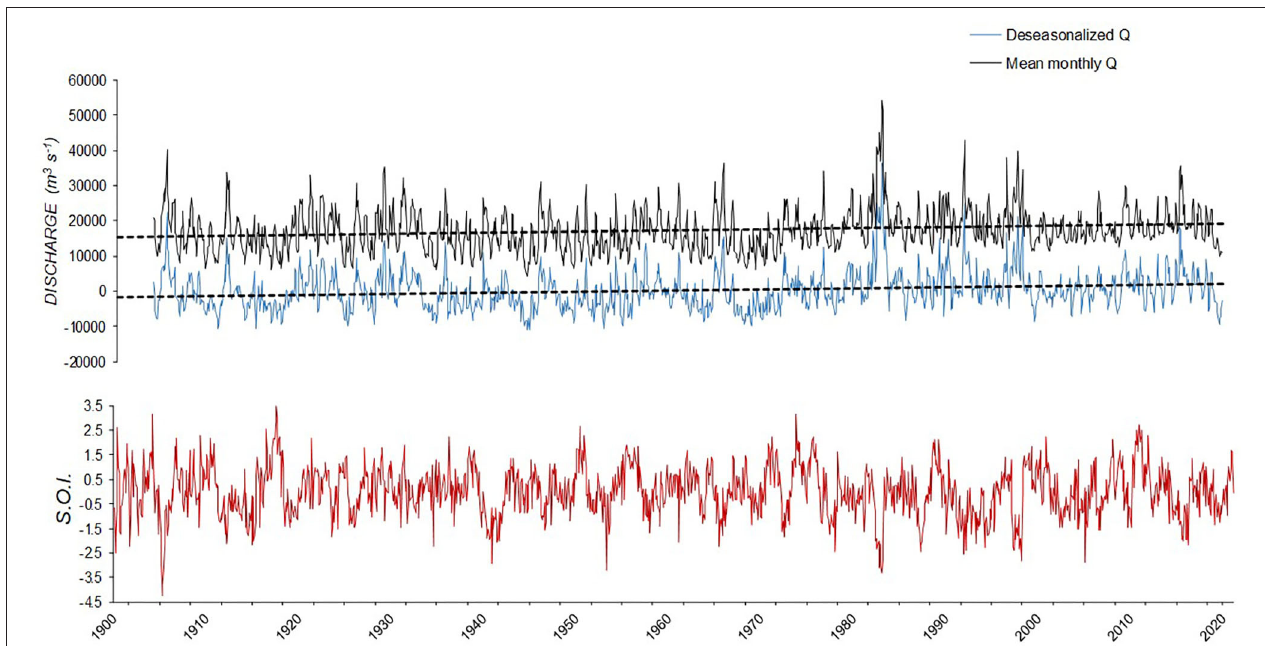
FIGURE 1 | Upper graphs: mean monthly discharge series (Q) of the Paraná River at the Corrientes gauging station (1200km upstream the mouth) and the corresponding deseasonalized series for the 1904-2020 period. Geometric mean discharge currently reached ∼ 16300 m 3 s − 1 . A positive trend (i.e., the slope of ∼ 300 m 3 s − 1 per decade showed little change over the last 20 years) resulted in a mean discharge increase of ∼ 3700 m 3 s − 1 over the ∼ 116 year interval. Lower graph: SOI variability 19 Notice the coherence between Q and ENSO events, particularly in the 1982-3 exceptional flood.